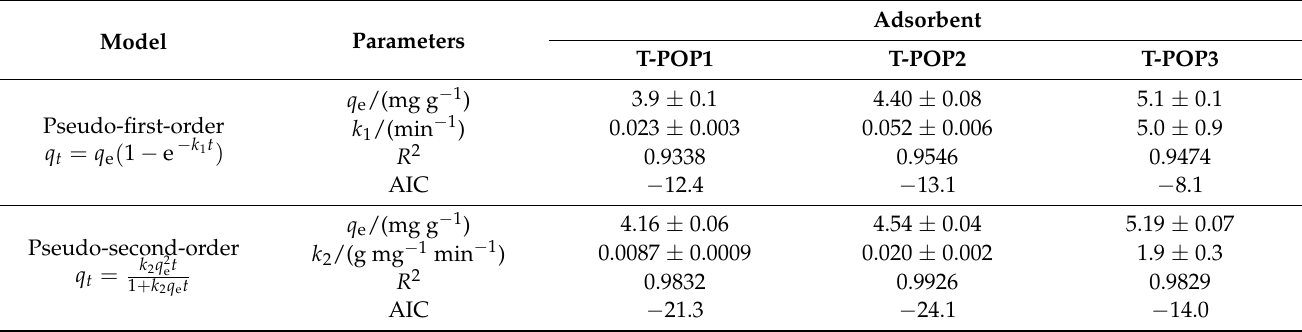
Figure 10. MB adsorption kinetics on different polymers at 25 °C, starting from a 10 mg L − 1 dye solution. The dashed lines represent the fit of the pseudo-second-order equation and the graph in the bottom right corner corresponds to a magnification between 0–25 min. Table 5. Fitting parameters of different kinetic models for MB adsorption.